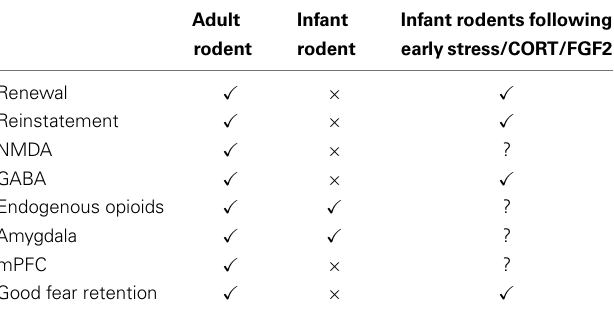
Table 1 | Summary of the behavioral and neural characteristics of the fear retention and extinction systems in adult and infant ( < P21)